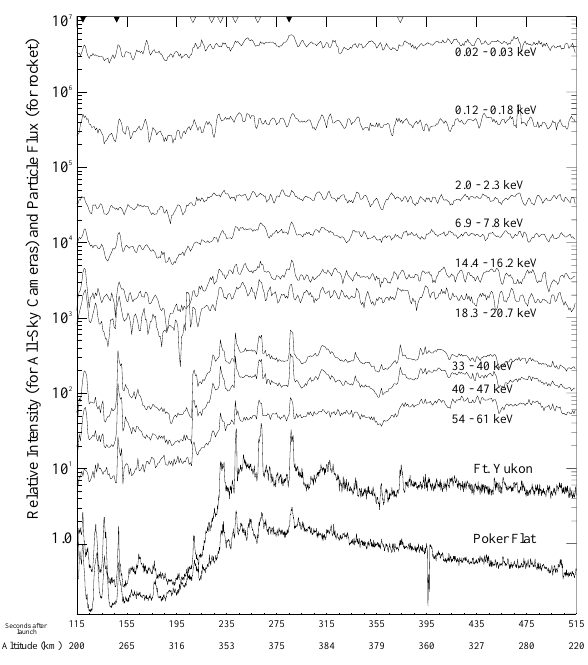
Fig. 2. Summary plot of electron flux for the field aligned (0–12 ◦ ) electrons for selected energies. The data are 1-s averages which have been smoothed with a 3-point filter. Nine pulsations are ev- ident as large abrupt changes in the flux and are indicated by the arrows. Three of the pulsations, marked by the solid arrows, show pulsation signatures down to 10eV. These higher energy electrons are not shown here but rather in Figures 5–7. The all–sky camera intensity, in relative units, is plotted below the particle flux. and is marked by the red dot. (A movie of the all-sky camera video for the entire flight from both Poker Flat and Ft.